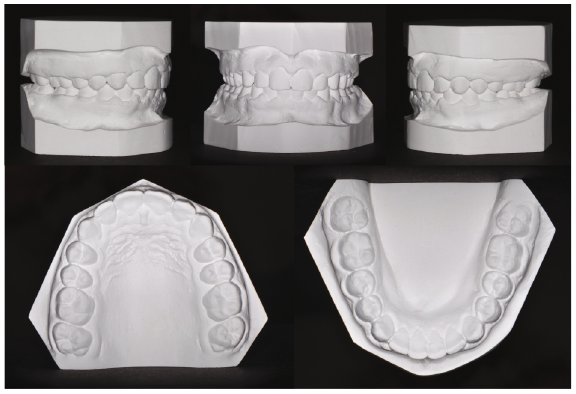
Figure 6: Posttreatment orthodontic study models.